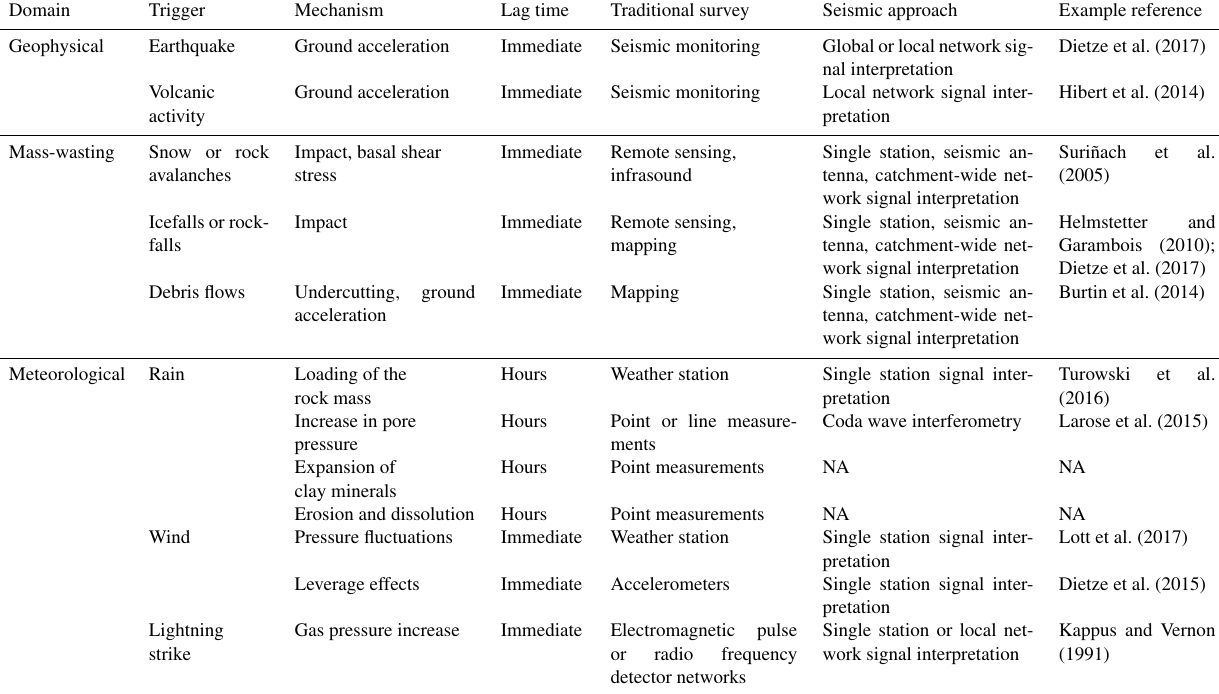
Table 1. Summary of rockfall triggers and potential approaches to survey and monitor them. Seismic approaches and their references were chosen based on existing links of trigger investigations and mass-wasting processes.